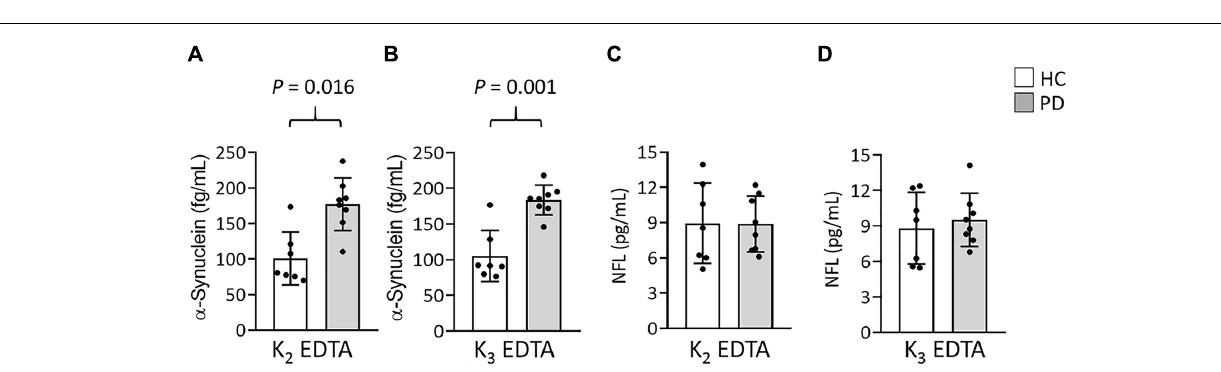
Figure 3E ). Bland-Altman plotting also confirmed that the differences between these two groups were small (1.99 ± 5.73 pg/ml, Figure 3F ). Under RT centrifugation, the levels of α -synuclein in PD patients (256.6 ± 50.2 fg/ml) were significantly higher compared with HCs (102.1 ± 0.66 fg/ml, P < 0.001, Figure 4A ). The sensitivity analysis confirmed the statistical significance following removing the outliers in PD group